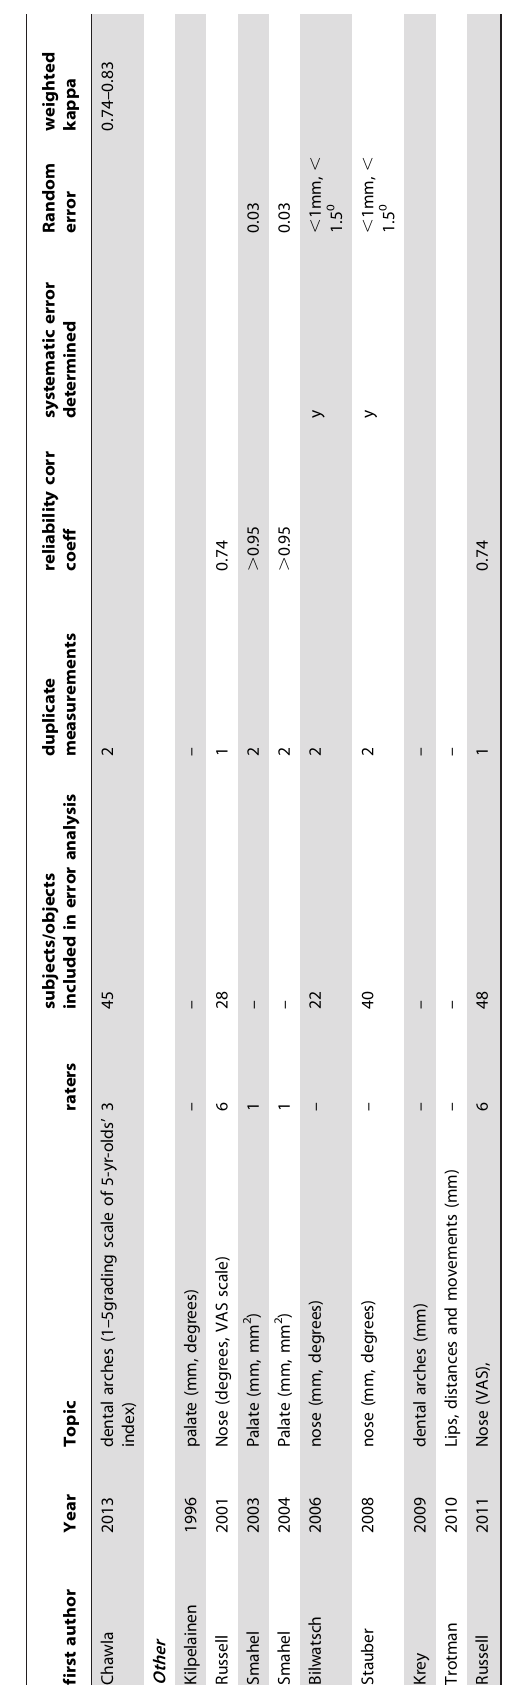
Table S1 Methodological quality scores of CT studies. Table S2 Methodological quality scores of CBCT studies. Table S3 Methodological quality scores of MRI